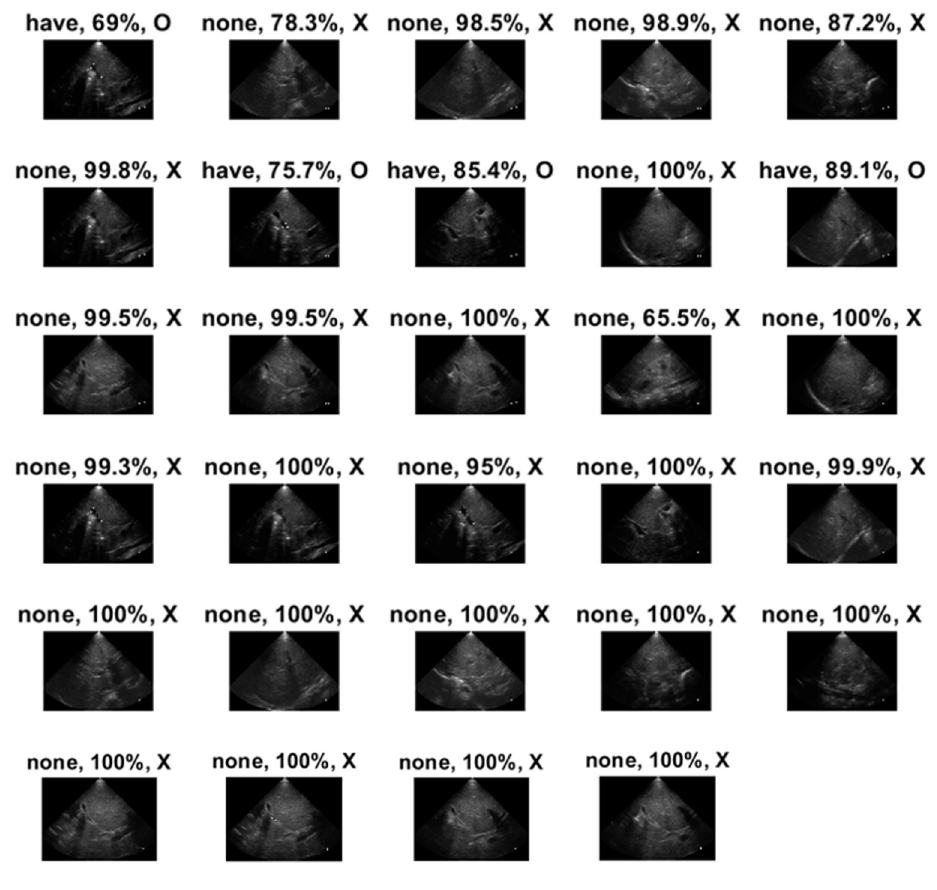
Fig 5. The detailed identification results of the “Have06” patient with BA. The first box above the image represents the prediction by the network model. The “have” and the “none” means BA was predicted and the non-BA, respectively. The second box represents the probability of the prediction. Meanwhile, the third box represents whether or not the judgment was correct (O is correct and X is